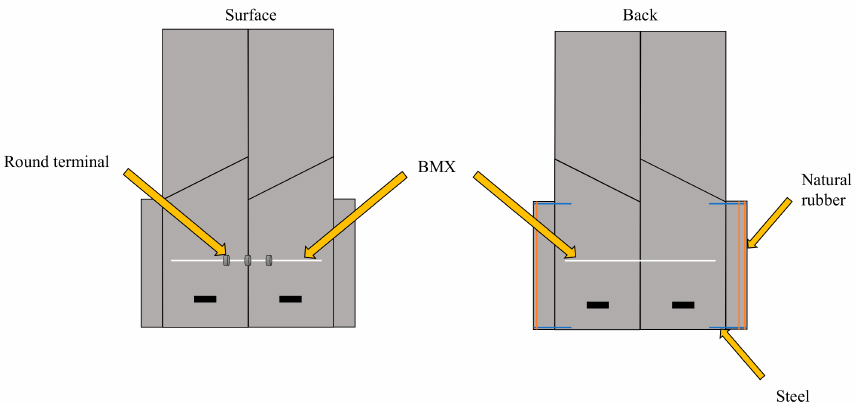
Figure 12. Components of sheet type robot.